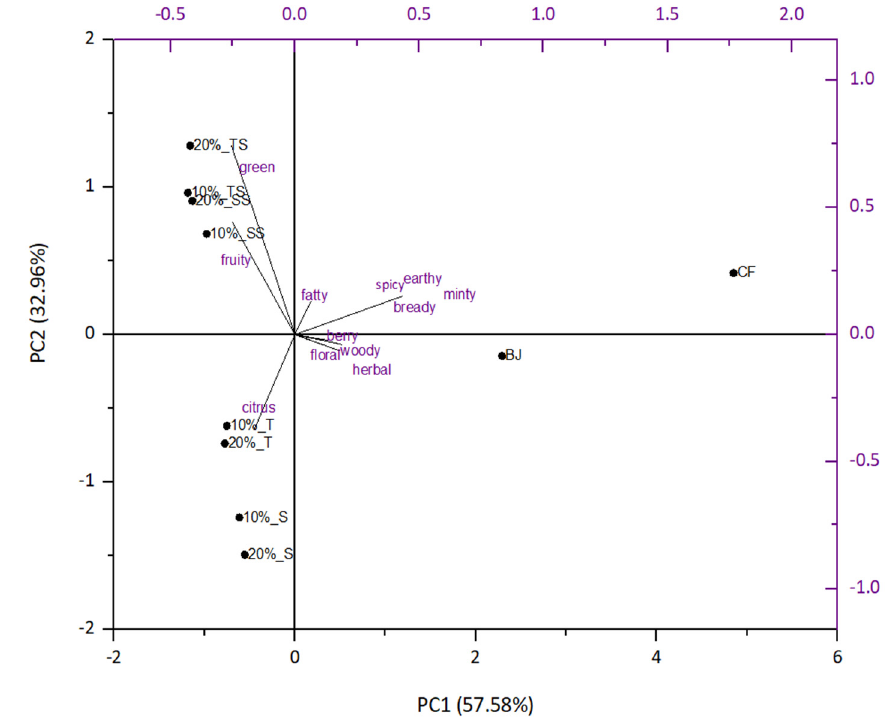
Figure 1. PCA analysis of citrus fiber/blackberry juice